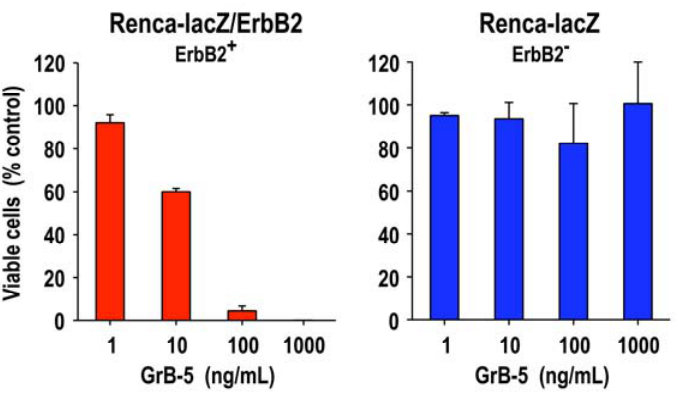
Figure 2. Cell killing activity and selectivity of an ErbB2-specific GrB - antibody fusion protein. ErbB2-expressing Renca-lacZ/ErbB2 (left panel) and ErbB2-negative Renca-lacZ renal carcinoma cells (right panel) were incubated for 14 h with the indicated concentrations of recombinant GrB-scFv(FRP5) (GrB-5) fusion protein in the presence of 50 µM chloroquine. The relative number of viable cells in comparison to controls only treated with chloroquine was determined in cell viability assays as described [23]. For